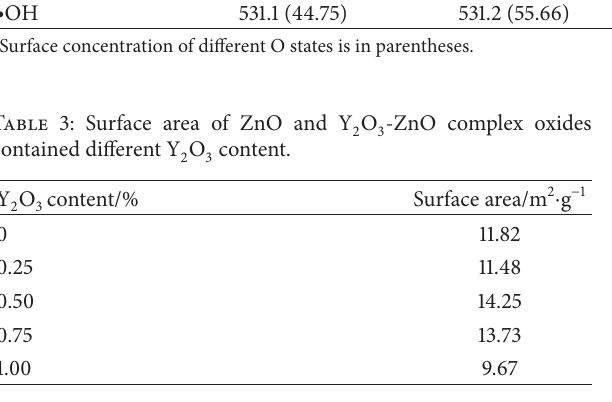
Table 2: Binding energy and the percent of valence state of O 1s in ZnO and Y Y O content/% 2 3